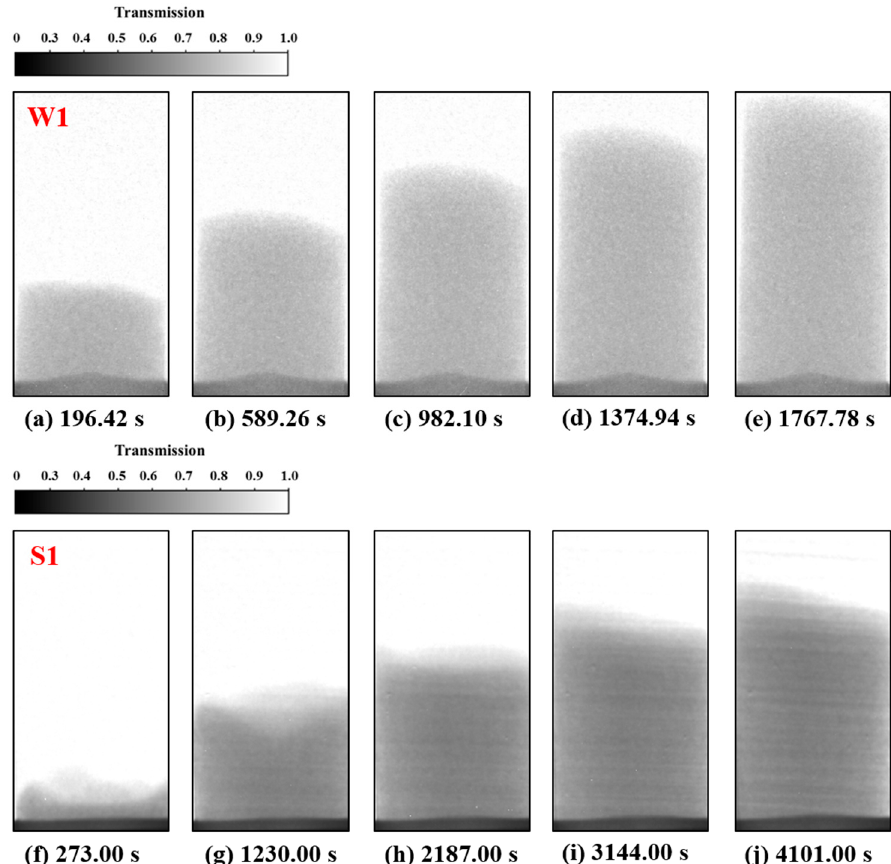
Figure 4. Selected net water transmission images of water imbibition in the tested specimens: ( a – e ) Typical sequential images of water imbibition in fine sandstone (W1) at various time points; ( f – j ) Typical sequential images of water imbibition in silty sandstone (S1). Darker areas denote higher moisture content.